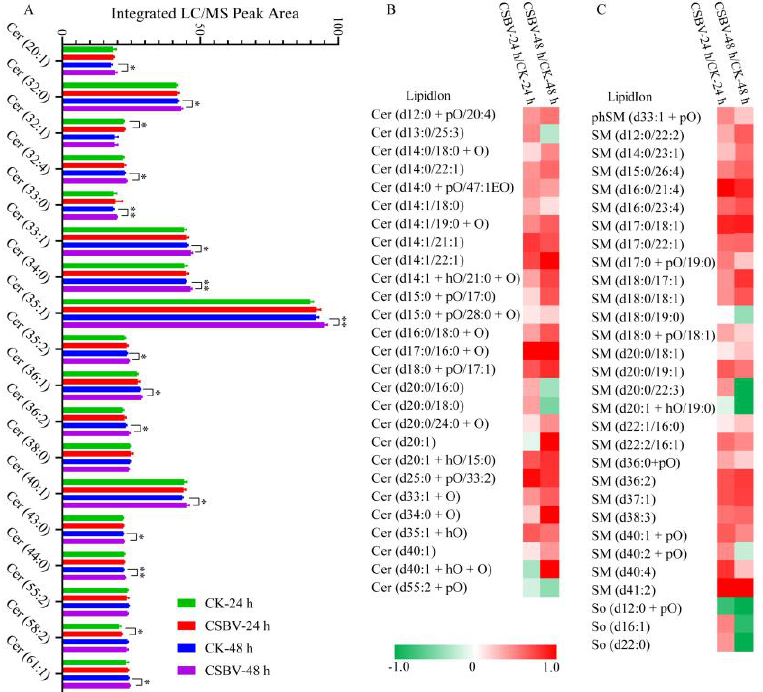
Insects 2021 , 12 , 703 13 of 15 Figure 8. Ceramide and sphingomyelin were regulated under CSBV infection. ( A ) The total relative content of ceramide (Cer) detected in CSBV-infection groups and healthy larvae. ( B ) and ( C ) are heatmaps of Log2 fold changes of ceramide (Cer) and sphingomyelin (SM) species, respectively. Asterisks (*) indicates statistically significant p -value of <0.05, ** p -value of <0.01.